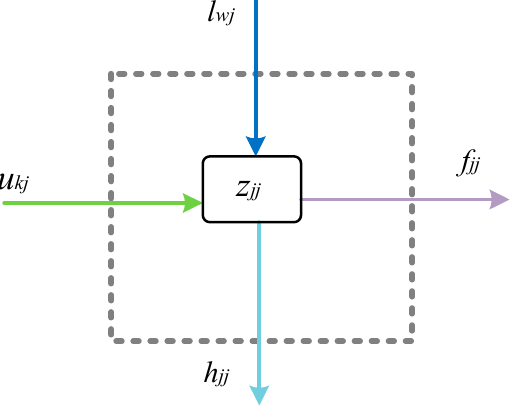
Figure 3. A generalised framework of an EMCE.